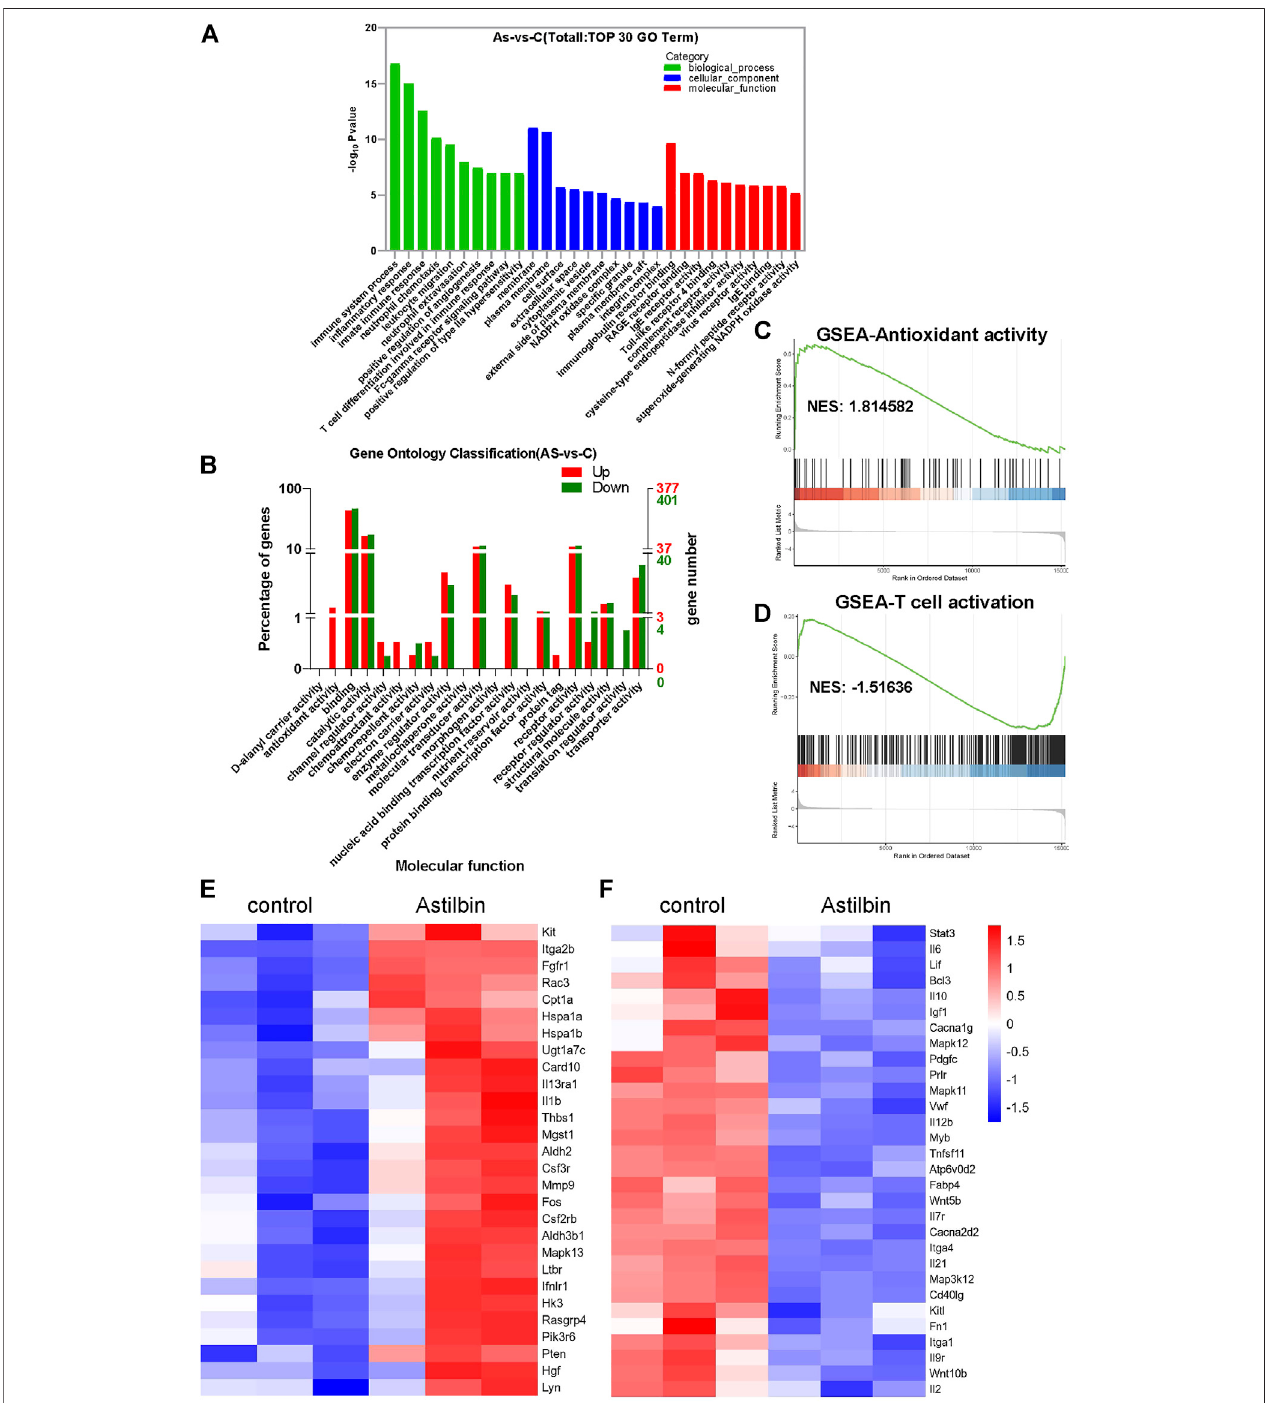
FIGURE 5 | Transcriptome analysis of astilbin-treated CD4 + T cell functions. (A) Top 10 changed genes in biological process, cellular component, and molecular function. (B) Numbers of differentially expressed genes in molecular function by gene ontology analysis. GSEA of signaling molecules involved in antioxidant activity (C) and T cell activation (D) . Heatmap of upregulated (E) or downregulated (F) genes involved in immune function.